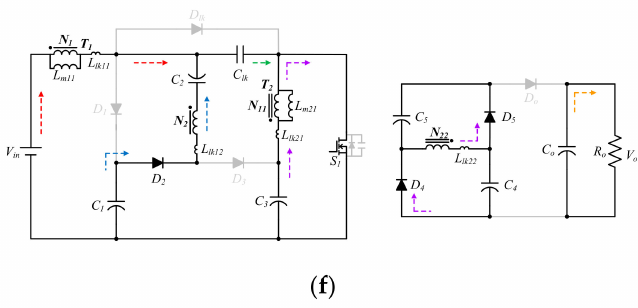
Figure 2. Mode equivalents of the proposed SIUSC over one switching cycle. ( a ) Mode 1 [ t 0 , t 1 ];